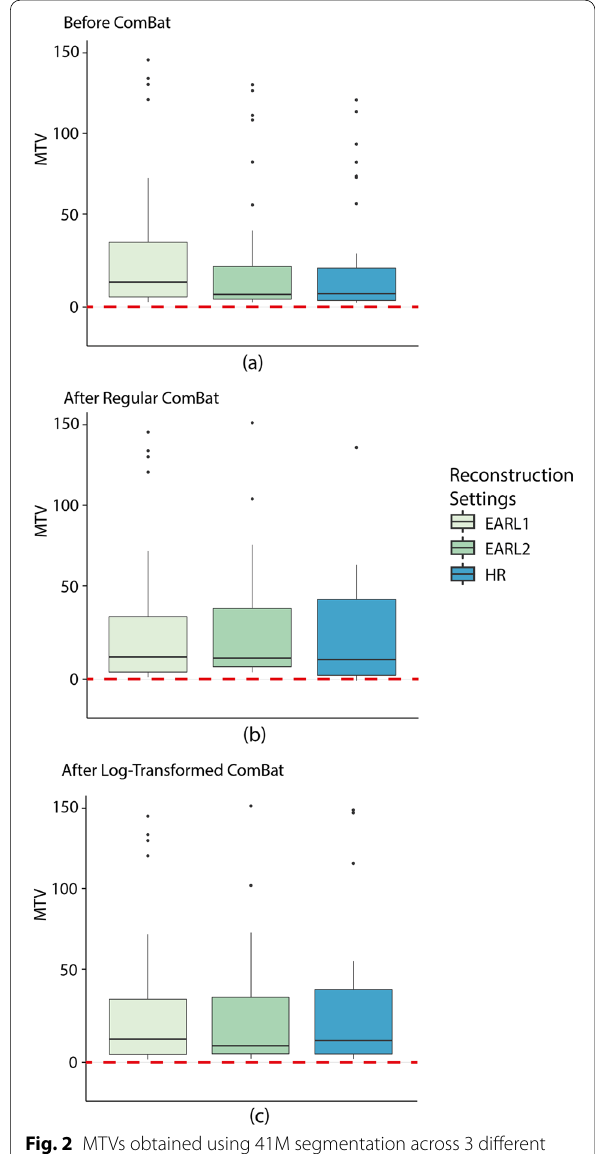
Fig. 2 MTVs obtained using 41M segmentation across 3 different reconstructions: EARL1, EARL2 and HR. a MTVs before ComBat harmonization. b MTVs after ComBat using non-transformed distribution (Regular ComBat). c MTVs after ComBat using log-transformed distribution (Log-transformed ComBat). Regular ComBat leads to negative volume values for the clinical reconstruction unlike Log-transformed ComBat which led